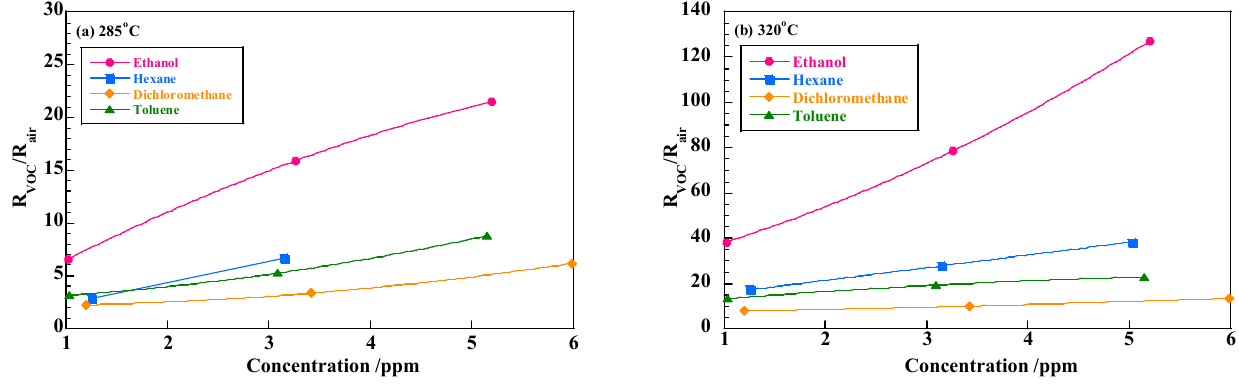
Figure 10. Sensor responses to VOCs with sample B at 285 ◦ C ( a ) and 320 °C ( b ).